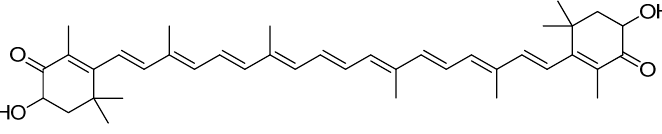
Figure 1. Chemical structure of astaxanthin.